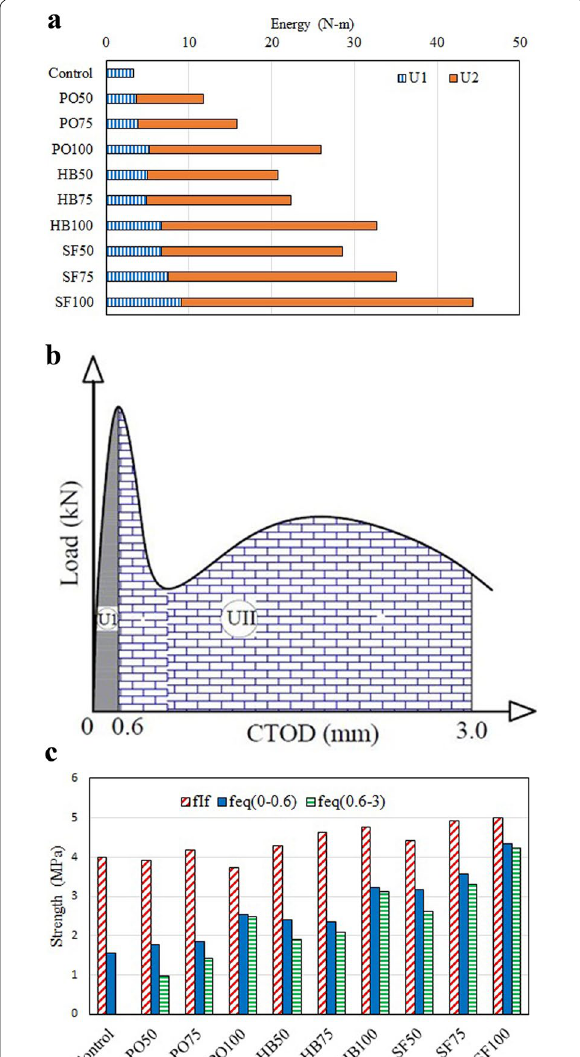
Fig. 5 a Normalised absorbed energies up to serviceability and ultimate CMODs, b flexural strength of PO, HB and SF specimens.